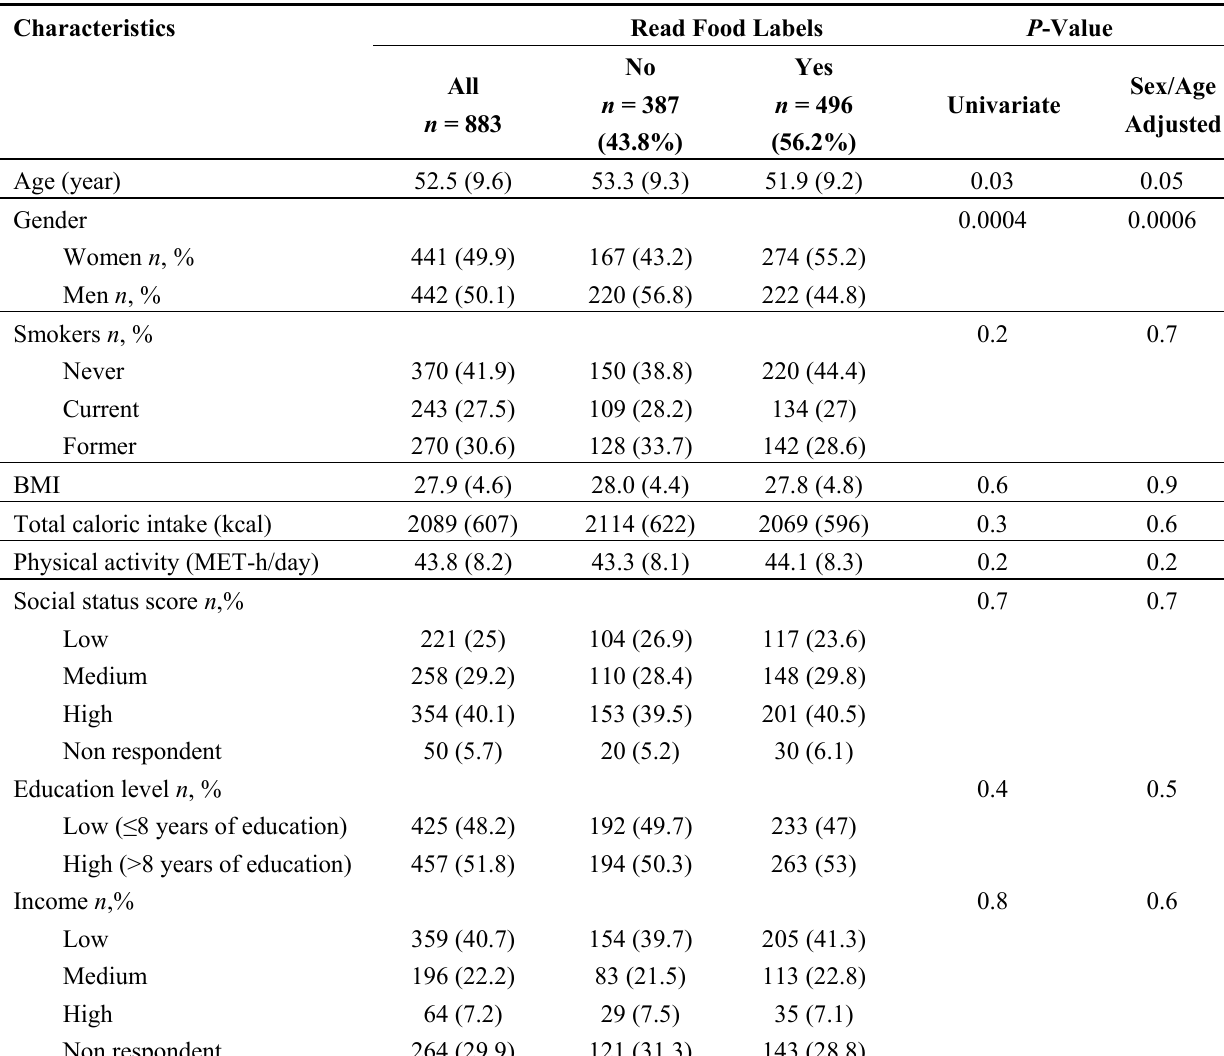
Table 3. Characteristics of the population